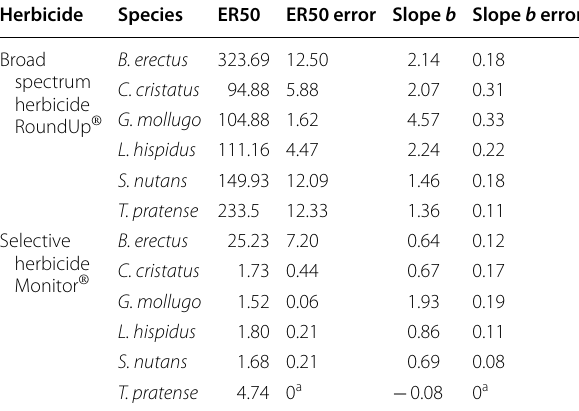
Table 4 Estimated ER50 values and slopes b for the 6 test species and the two herbicides including the standard errors (see Additional file 1: Appendix D for all dose– response curves)